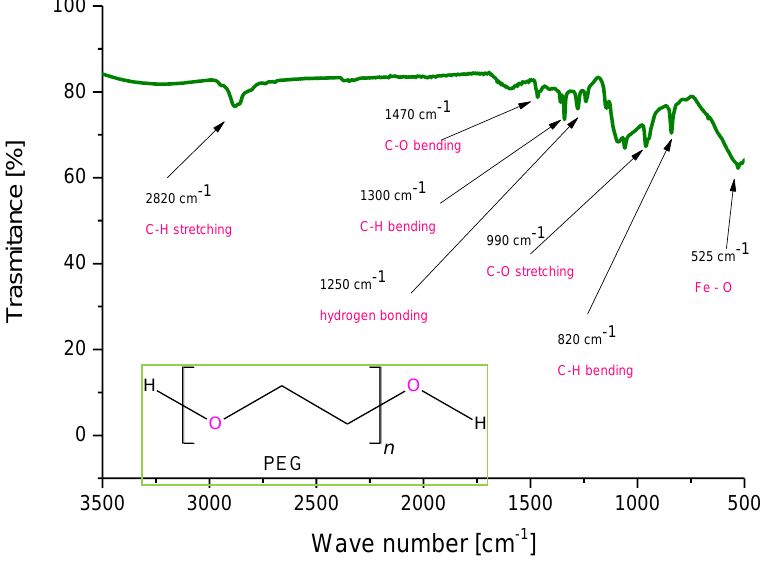
Figure 11. FT-IR spectrum of Fe 3 O 4 @Ag@PEG particles.